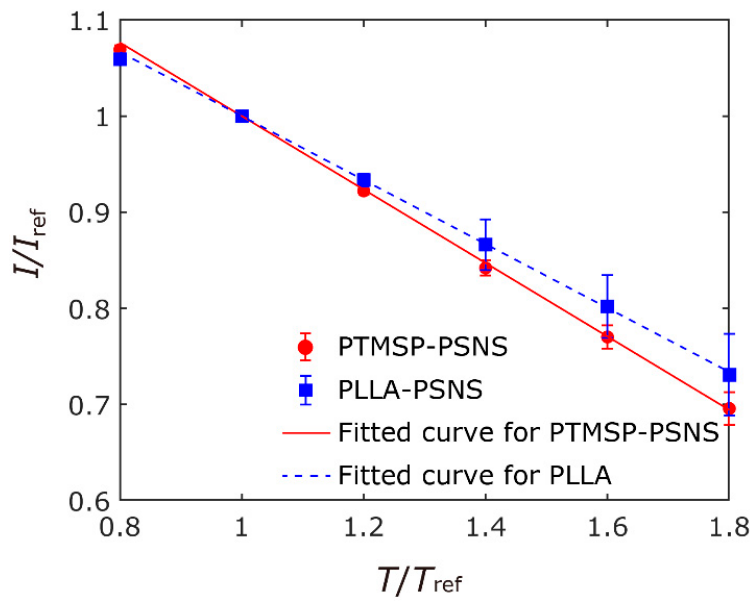
Figure 4. Result of temperature calibration tests for PTMSP-PSNS and PLLA-PSNS samples Table 1. Quantum yields of PTMSP-PSNS and PLLA-PSNS.